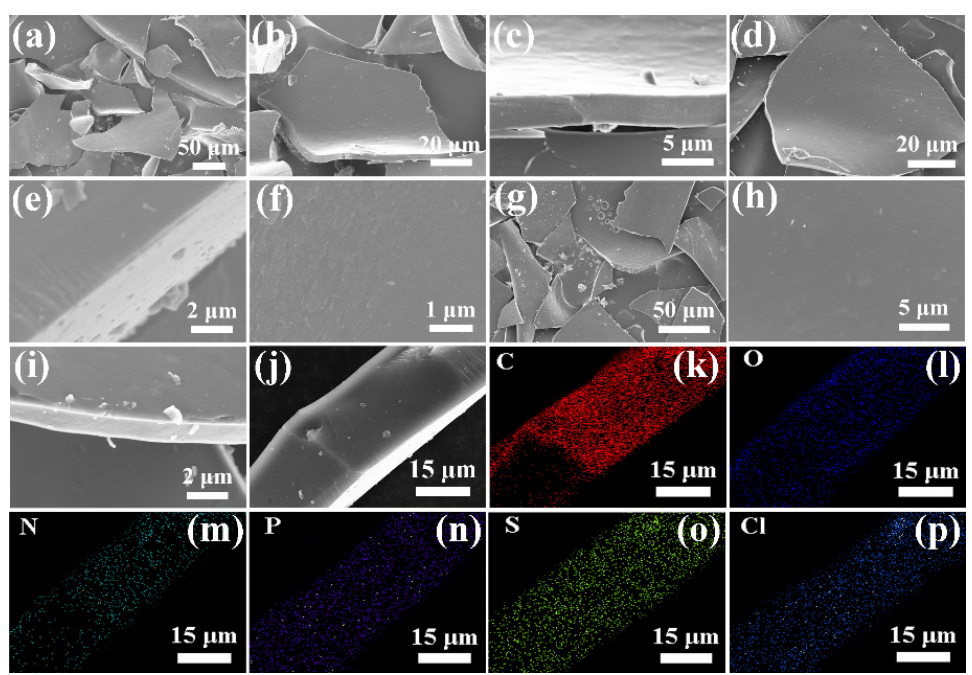
Figure 2. SEM images with different magnification of ( a – c ) 5 − 3H, ( d – f ) 6 − 3H, ( g – i ) 7 − 3H; element mapping of ( j – p ) 6 − 3H.